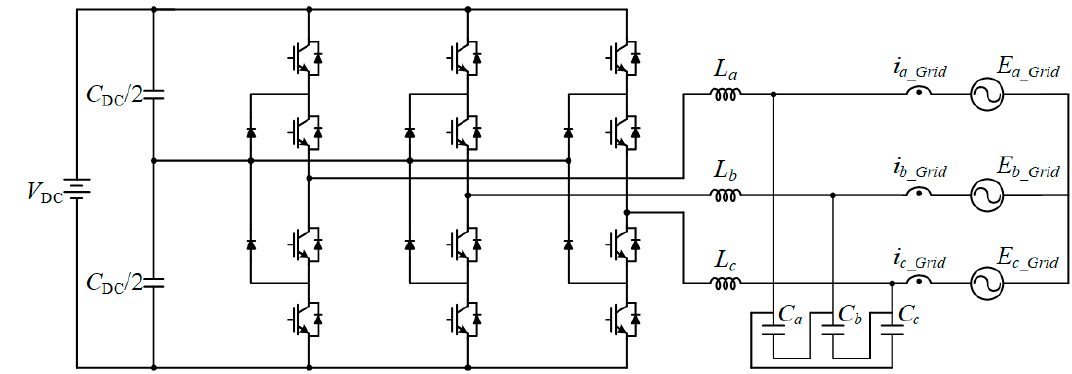
Figure 12. Simulation circuit configuration for the harmonic compensation method (three-level NPC inverter). NPC: neutral point clamped.